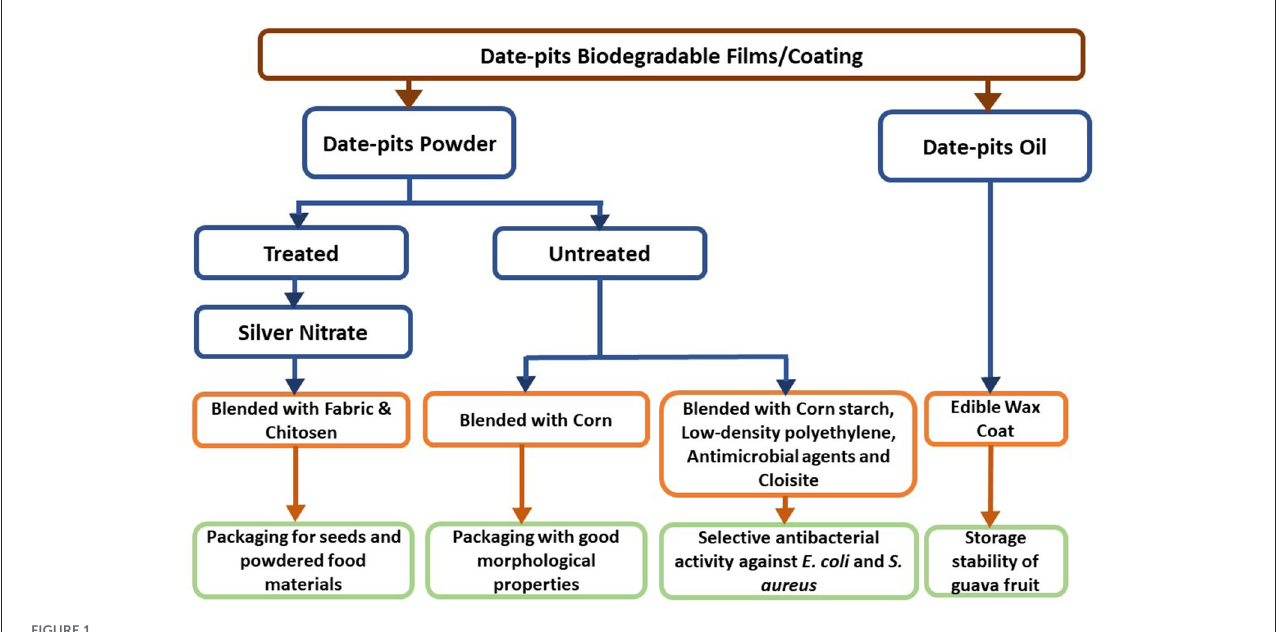
FIGURE1 Date pits in biodegradable films and